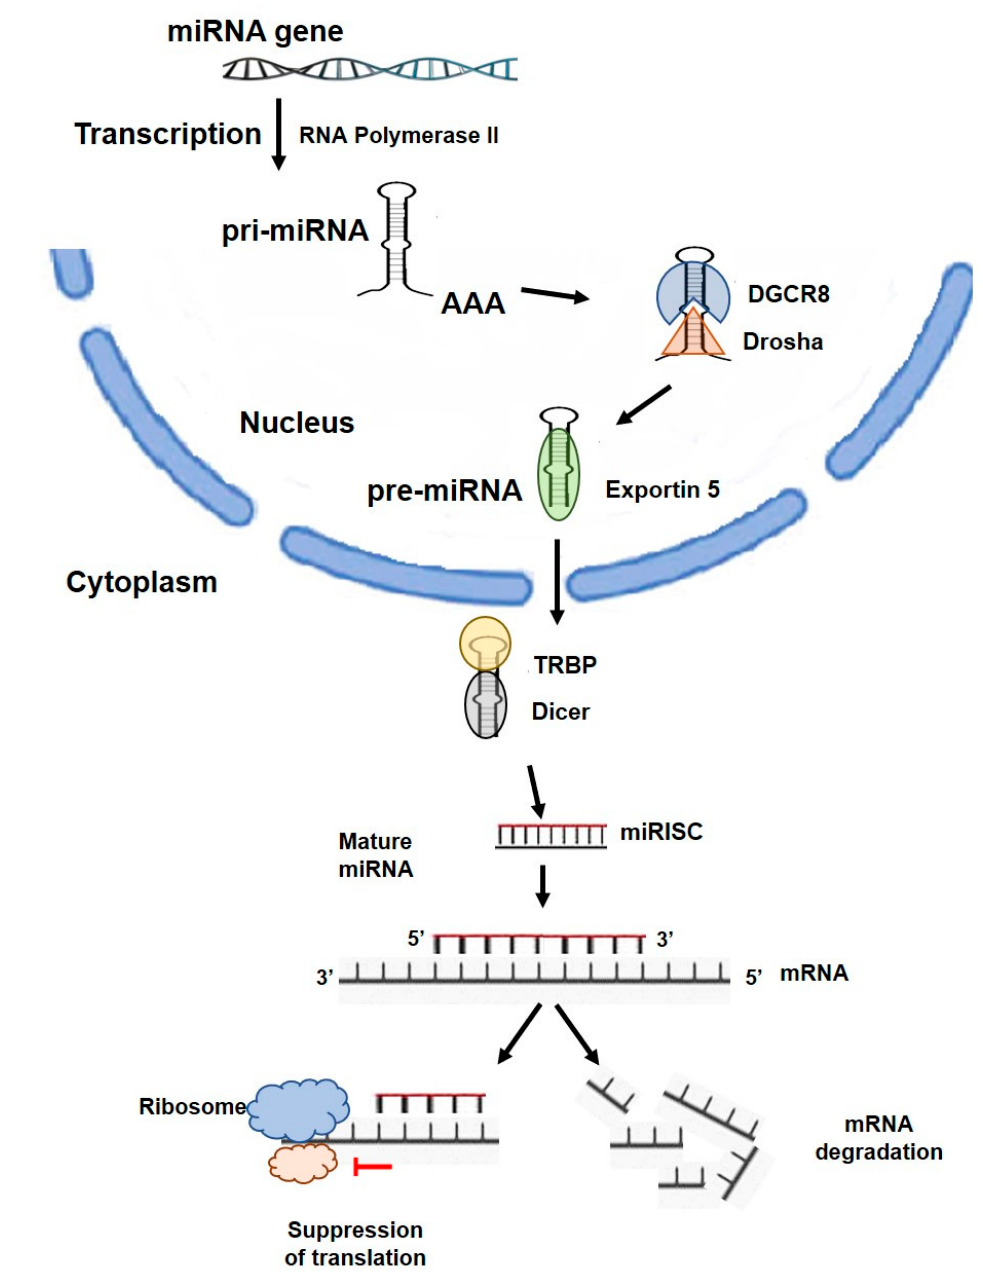
Figure 1. miRNA structure and biogenesis. miRNA genes are mainly transcribed by RNA polymerase II in the nucleus to produce pri-miRNA transcripts. The microprocessor complex, composed of the RNase III enzyme Drosha and the dimeric RNA-binding protein DGCR8, produces the pre-miRNA precursor product by cleavage of pri-miRNA. The pre-miRNA is transferred to the cytoplasm by exportin 5 (XPO5). A complex composed of the Rnase III enzyme Dicer and the transactivation response element RNA-binding protein (TRBP) cleaves the pre-miRNA into a mature double-stranded miRNA. A mature miRNA is then incorporated into the miRNA-associated multiprotein RNA-induced silencing complex (mi-RISC). The mature miRNA then binds to complementary regions in the target mRNA and acts as a guide through base pairing with the mRNA to modulate its expression. In most cases, the mature miRNA binds to the 3 ′ -untranslated sequences (3 ′ -UTR) of specific mRNAs via partially complementary sequences and inhibits the translation of the mRNAs into protein. If there is high complementarity between the miRNA and the mRNA, this leads to cleavage of the target mRNA.